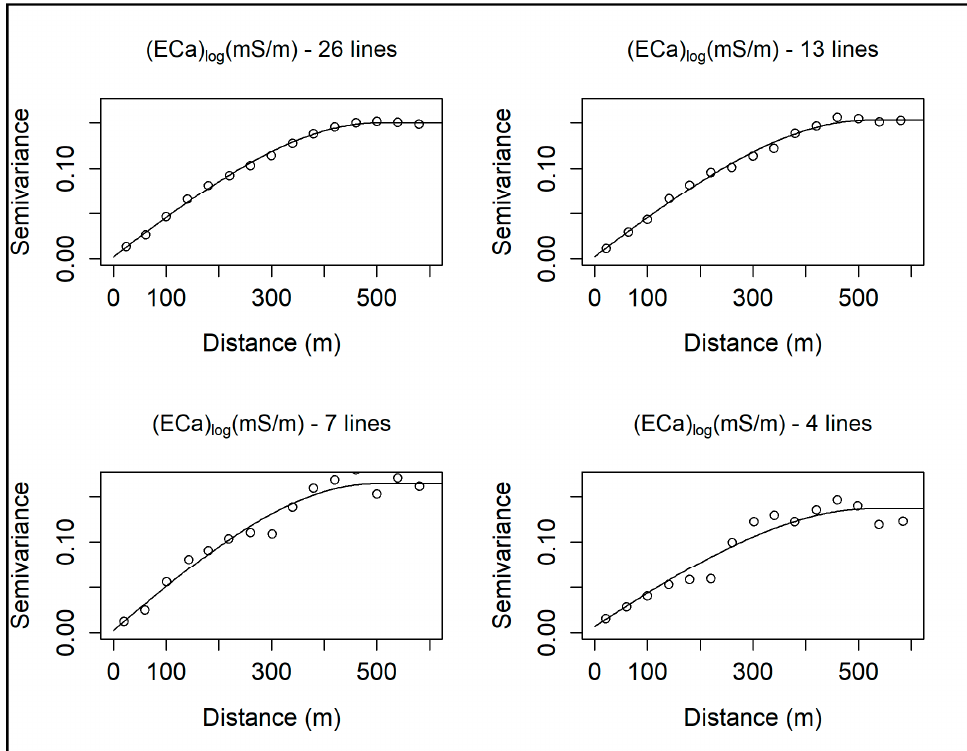
Figure 5. Empirical (circles) and adjusted (lines) variogram models for natural logarithm of soil ECa datasets from different numbers of transect lines (i.e., 26, 13, 7, and 4).